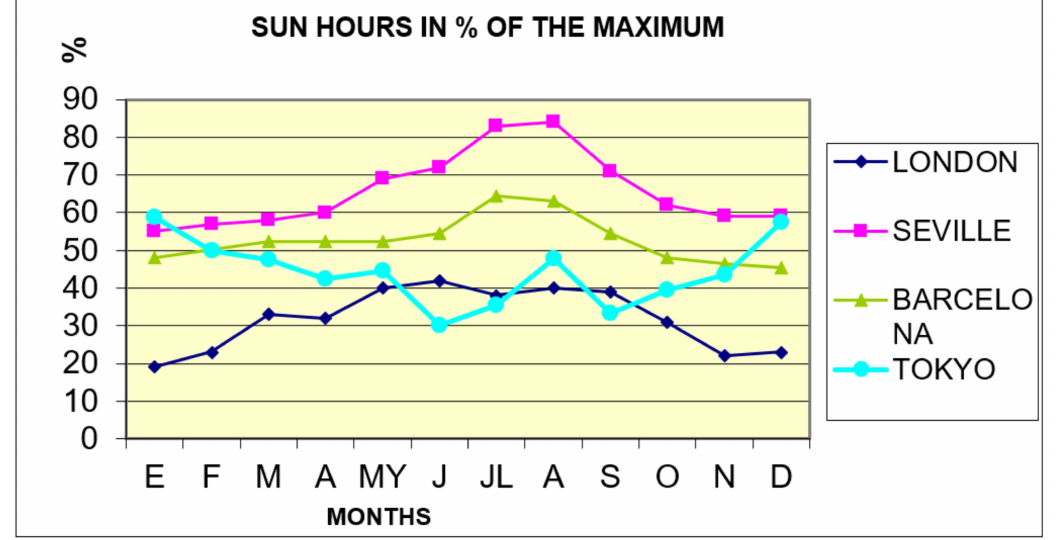
Figure 9. The sunlight distribution by months, in terms of percentage, at four different locations: London, Seville, Barcelona, and Tokyo.